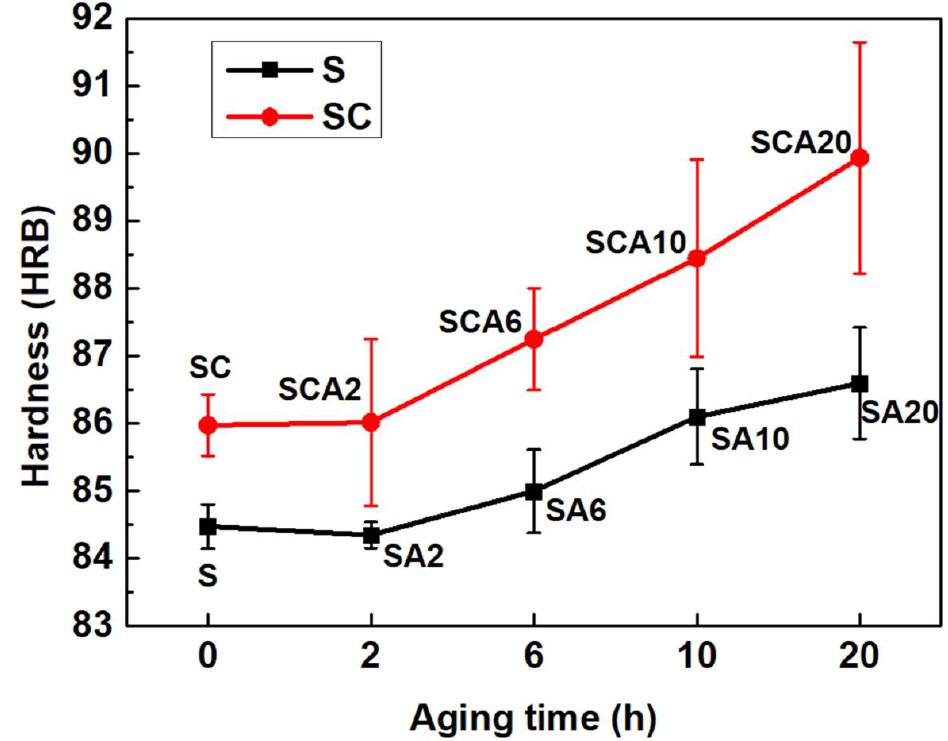
Figure 4. The hardness variations of 15%SiCp/2009Al composites with different aging times. In order to investigate the effect of cryogenic treatment and its combination sequence with traditional heat treatment on 15%SiCp/2009Al composites, samples treated with SA20, SA20C, and SCA20 underwent tensile tests. The results are compared and shown consistent in the tensile process for all the specimens. The tensile strength, yield strength, and elongation can be obtained from these curves, as is shown in Figure 6. It can be ob- served that SA20C shows a slight improvement in tensile strength, while SCA20 demon- strates the opposite effect. However, this change in tensile strength is too small and can be ignored. Both SA20C and SCA20 can improve the yield strength of the 15%SiCp/2009Al composites. The improvement caused by SCA20 is more effective, being 16 MPa higher than that of the SA20 sample. The tendency of reduction in elongation can be observed. Due to the relatively poor plasticity of aluminum matrix composites and the discreteness of elongation, this reduction can also be ignored. Therefore, the most obvious effect caused by cryogenic treatment is the improvement in yield strength when cryogenic treat- ment is performed after solution and prior to aging treatment.